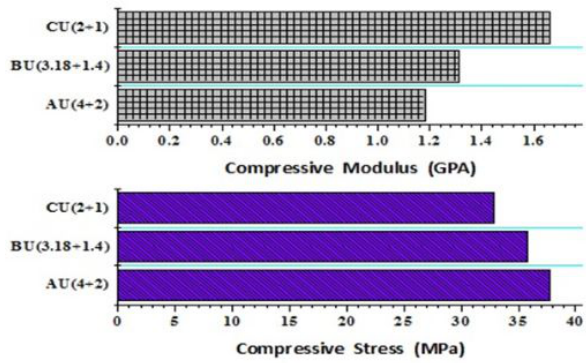
Figure 4: Graph of PC compressive strength and modulus